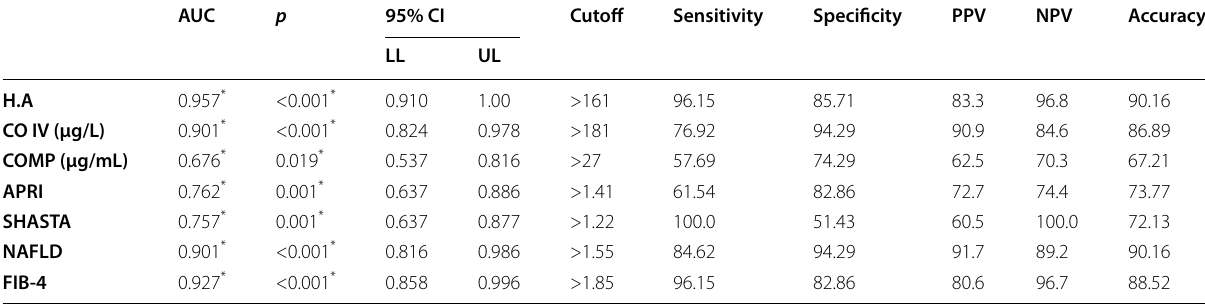
Table 2 Presentation of sensitivity and specificity and accuracy of serum biomarkers levels and fibrosis scoring systems to differentiate advanced from early stages of liver fibrosis in HCV patients